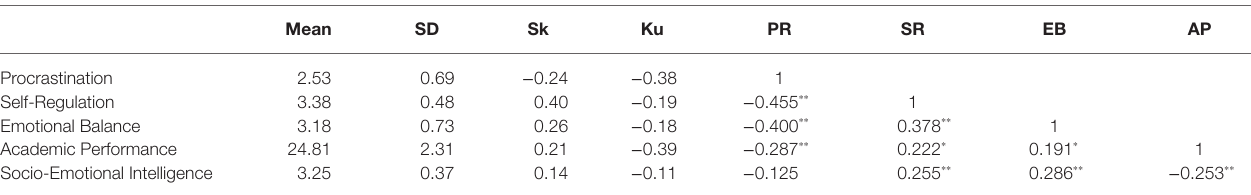
TABLE 1 | Variables means and bivariate correlations. Mean SD